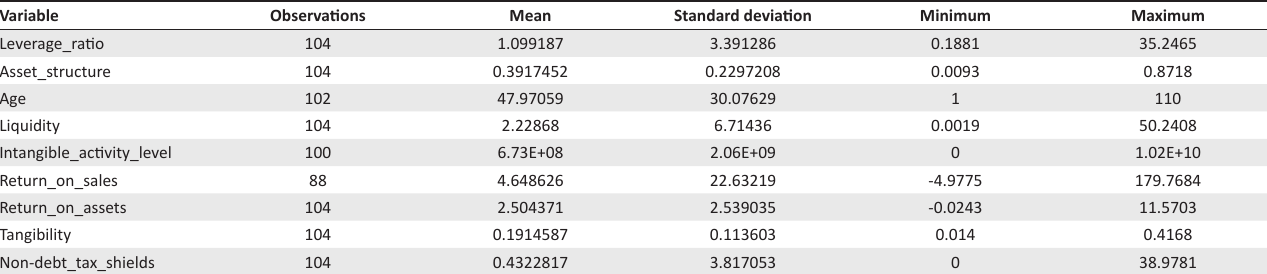
TABLE 1-A1: Summary